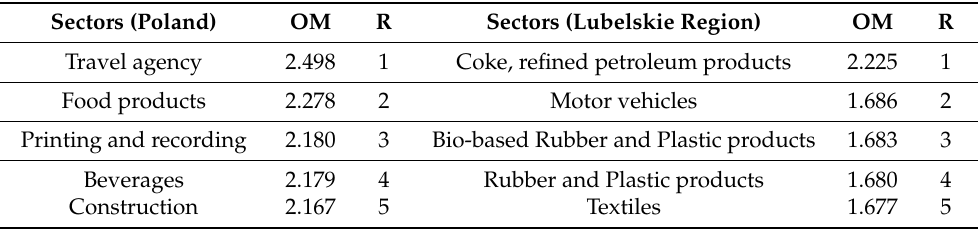
Table 5. Sectors with the highest output multipliers in Poland and the Lubelskie Region (OM = Output Multiplier; R = Rank).